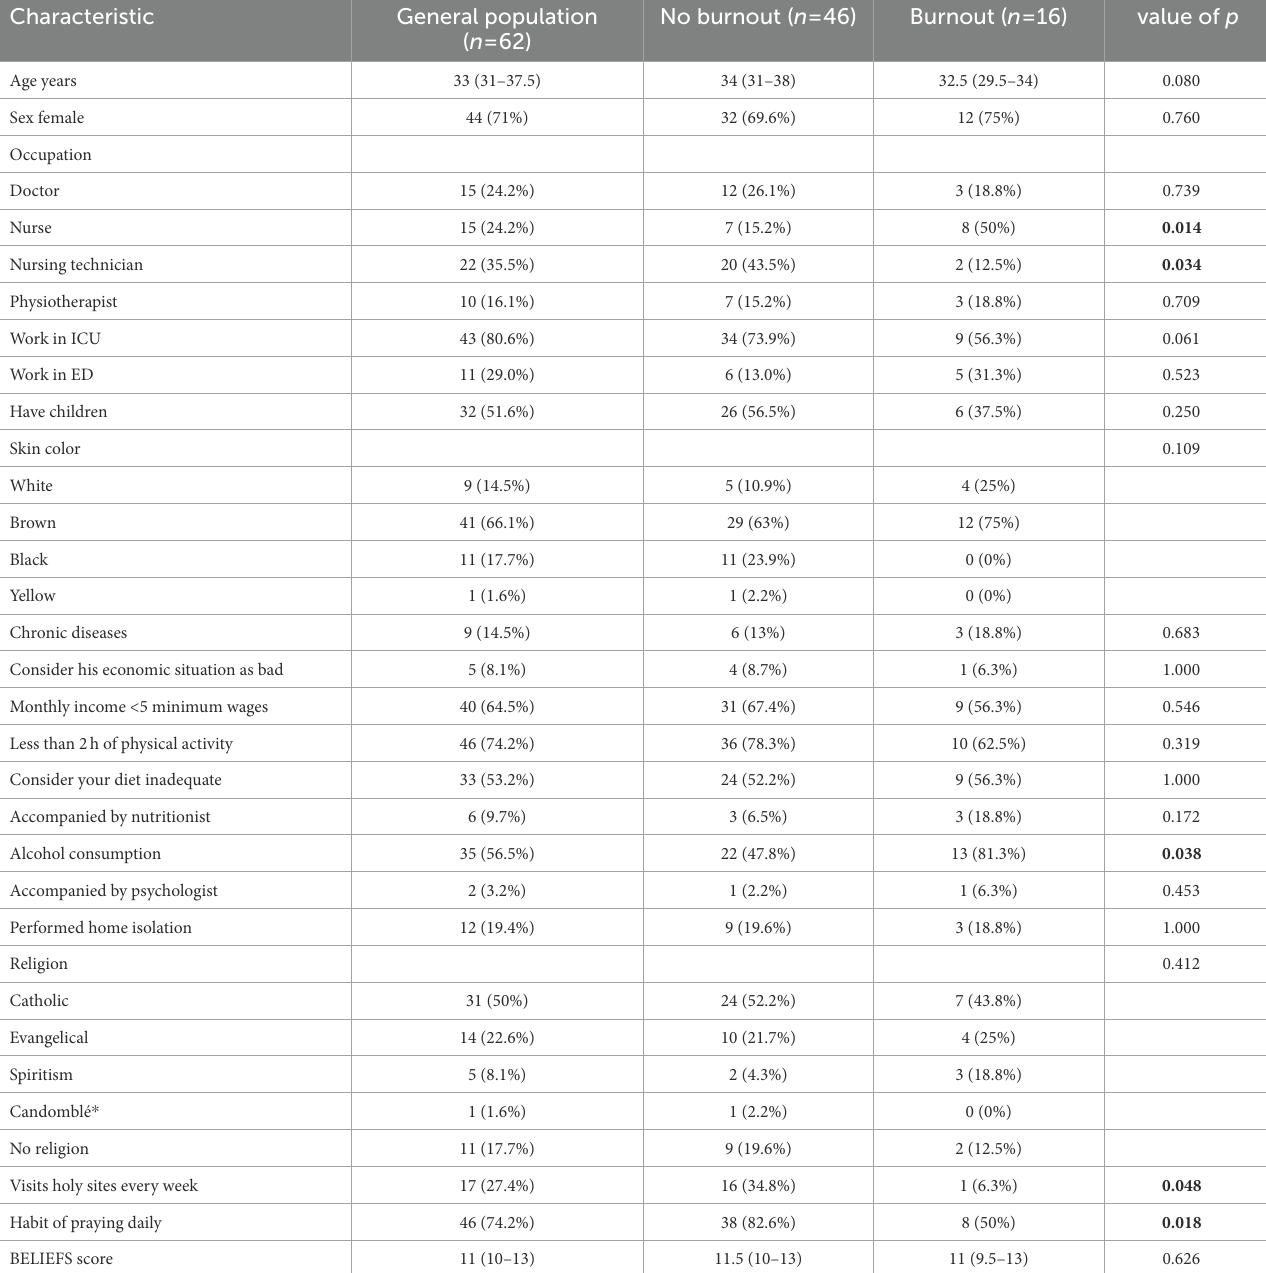
TABLE 1 Comparison according to the development of